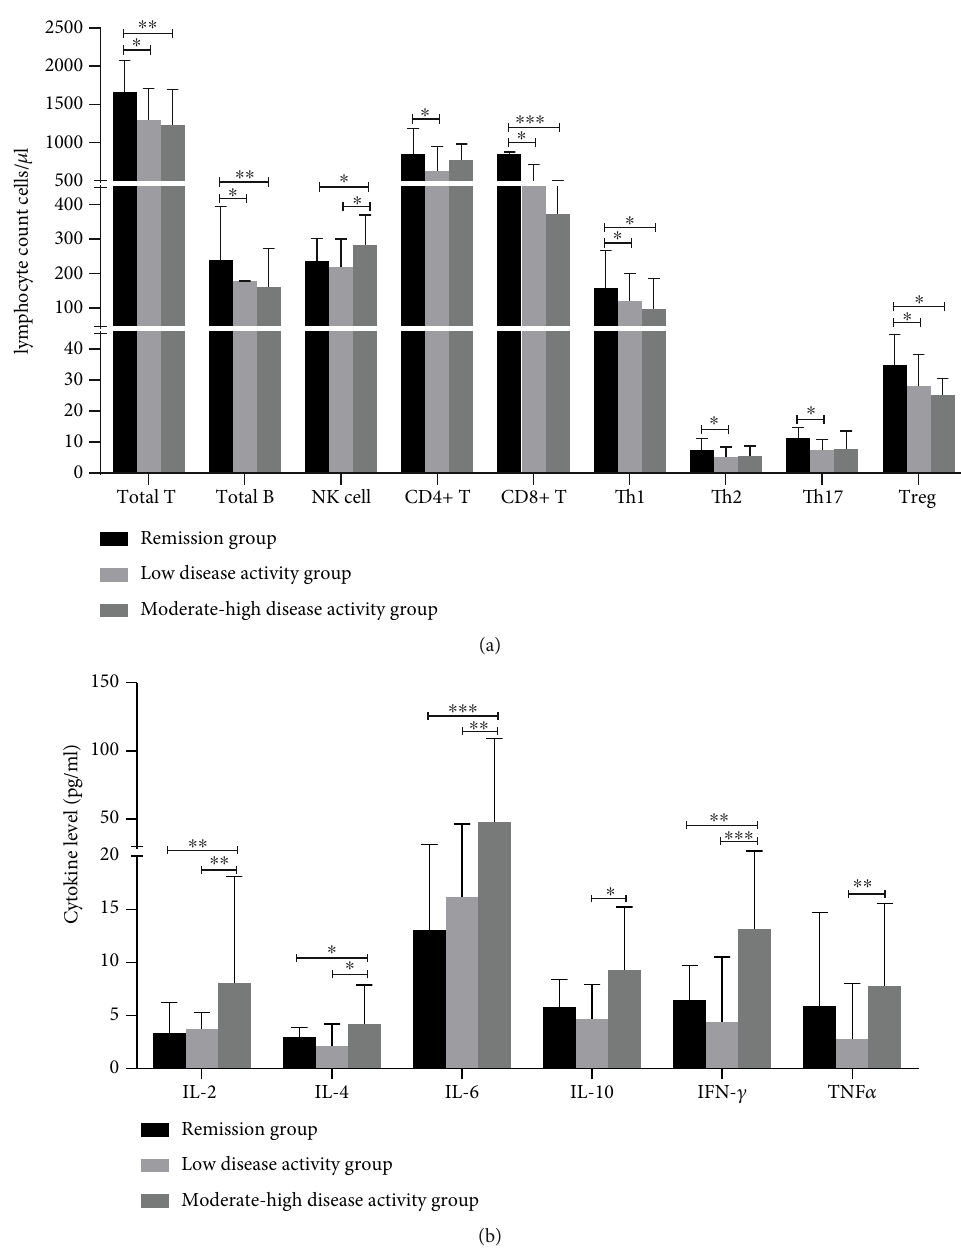
Figure 2: (a) Comparison of absolute lymphocyte and CD4+ T cell subset counts among the remission group ( n = 33 ), low disease activity group ( n = 38 ), and moderate-high disease activity group ( n = 35 ). (b) Comparison of serum cytokine levels among the remission group ( n = 33 ), low disease activity group ( n = 35 ), and moderate-high disease activity group ( n = 38 ) ( ∗ p < 0 : 05 , ∗∗ p < 0 : 01 , and ∗∗∗ p < 0 : 001